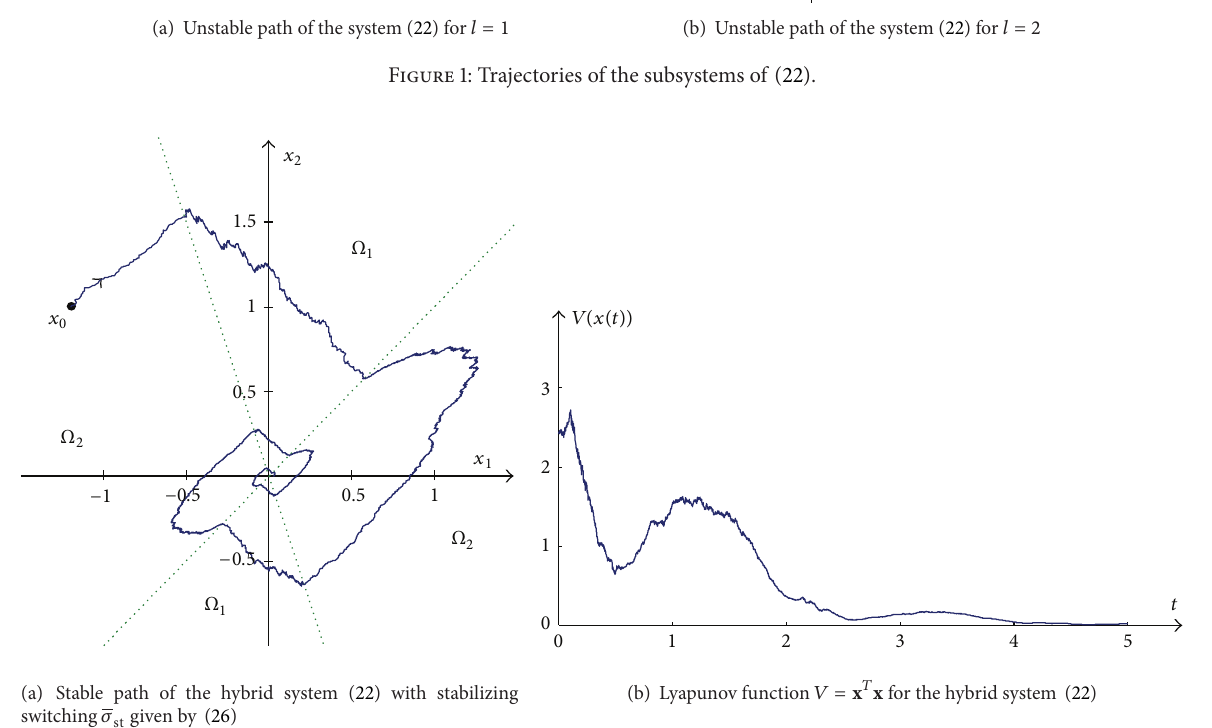
Figure 2: Trajectories of the hybrid system